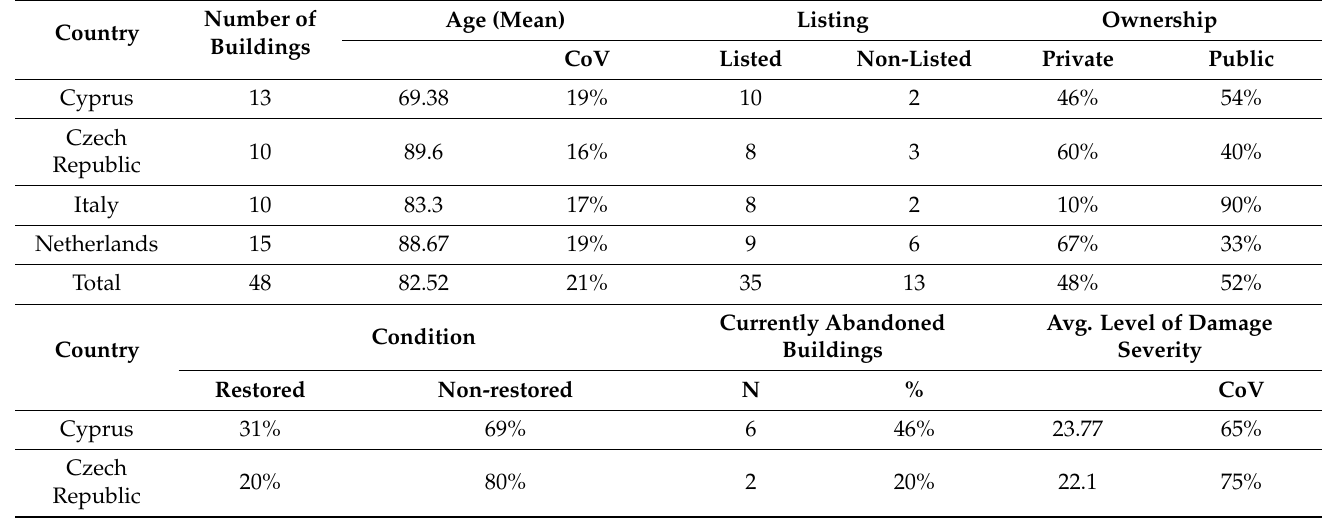
Table 1. General characteristics of the buildings used as screening cases in